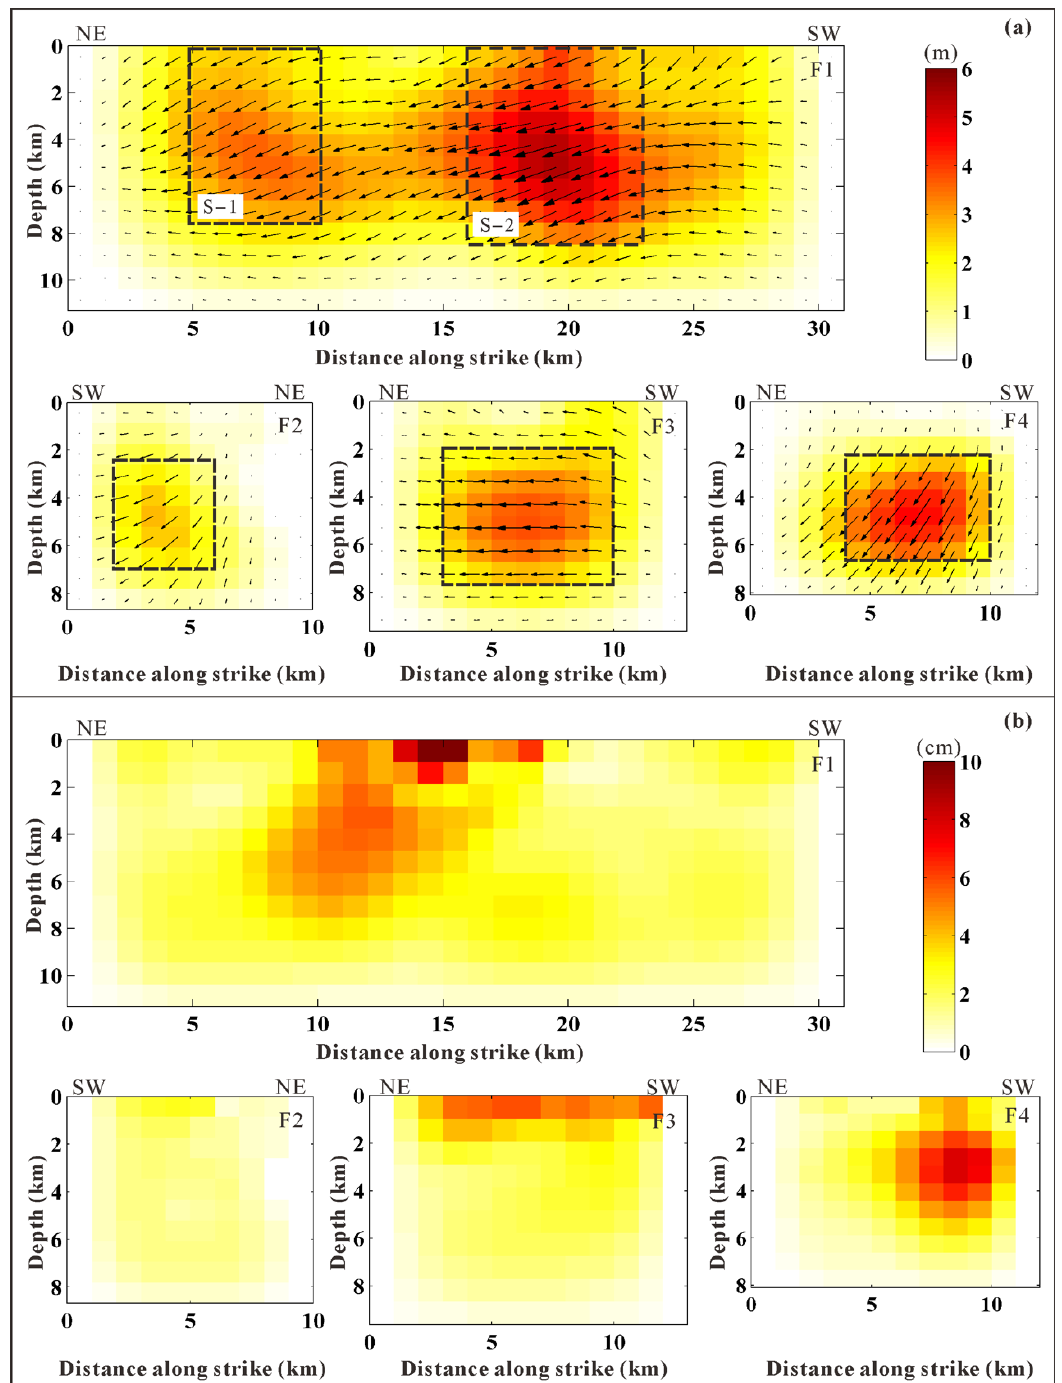
Figure 8. Fault slip model ( a ) of the Kumamoto earthquake estimated by the joint utilization of ground observations from three-track InSAR and the corresponding error distributions ( b ) on the fault planes. Dotted rectangles denote the high slip concentrations.